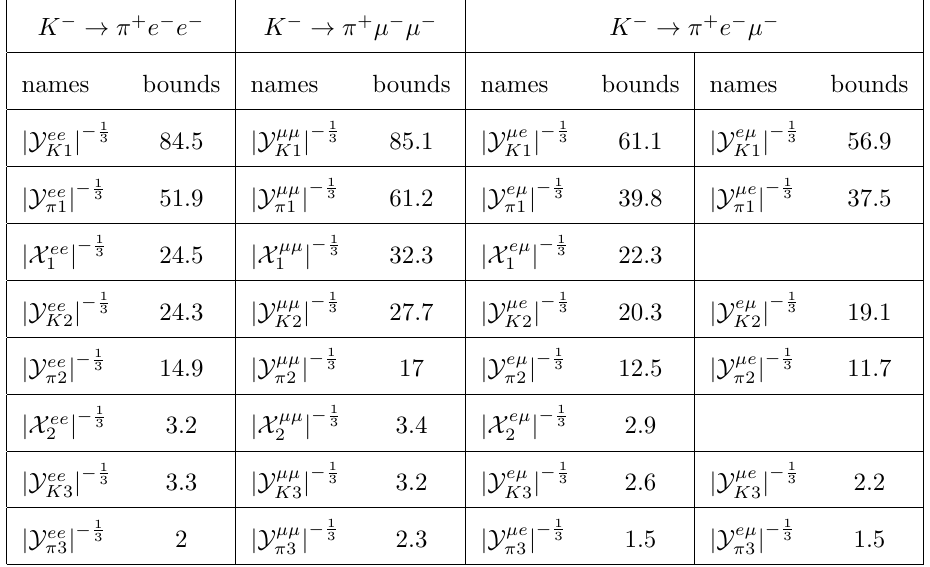
Table 1 . Lower bounds (in units of GeV) are shown for inverse cubic roots ( jX i j (cid:0) 1 = 3 or jY i j (cid:0) 1 = 3 ) of combinations of Wilson coe(cid:14)cients for dim-7 operators in SMEFT. Note that X (cid:11)(cid:12)